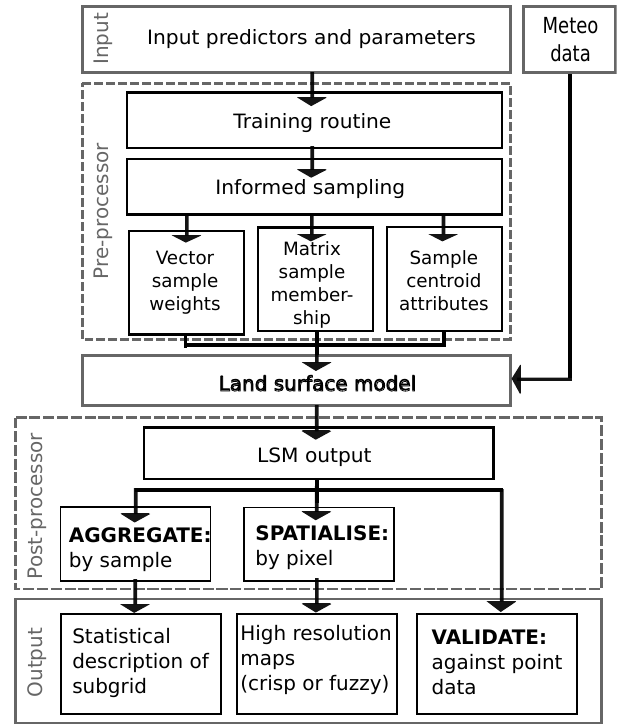
Fig. 3. Structure of the TopoSUB scheme with its two main mod- ules: (1) pre-processor configures the sub-grid (runs once), (2) post- processor (runs multiple times together with the